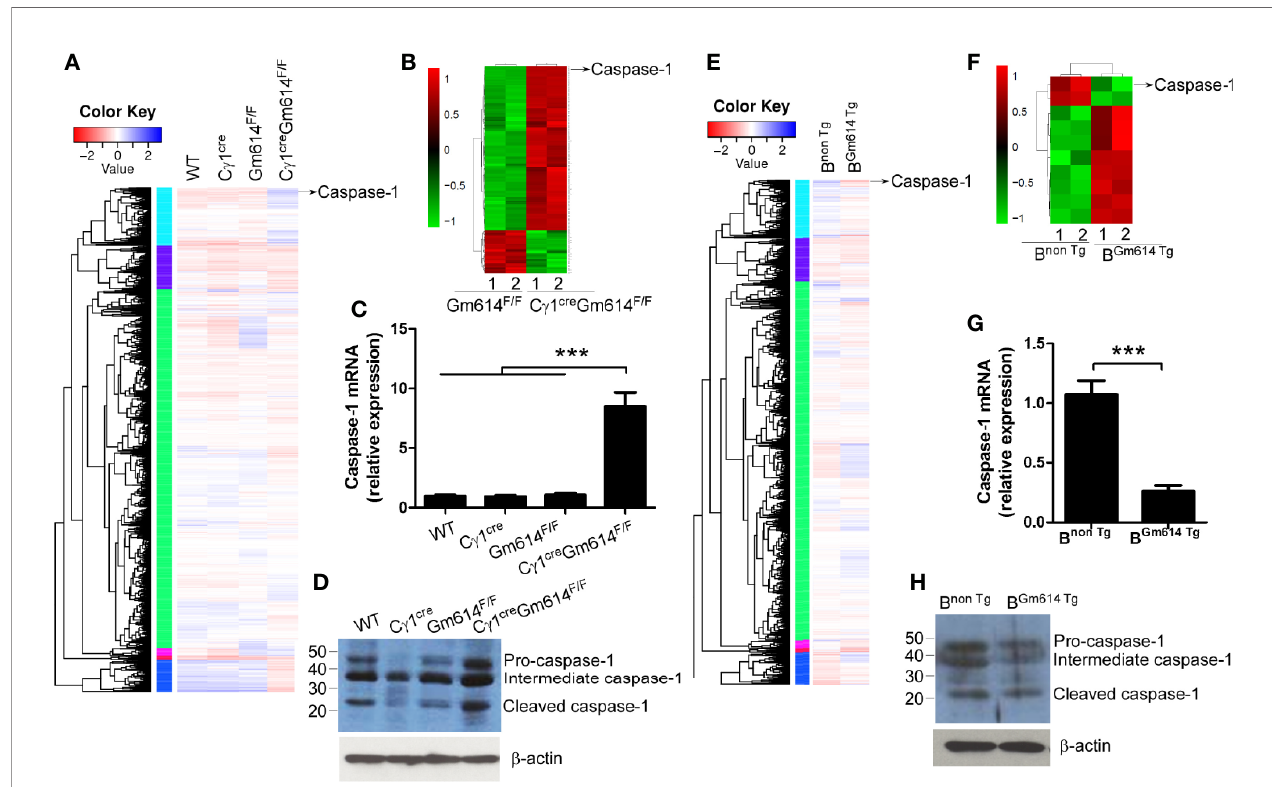
FIGURE 5 | Gm614 suppressed caspase-1 expression in GC B cells. Nine-week-old WT, C g 1 cre , Gm614 F/F , and C g 1 cre Gm614 F/F (A – D) , or B non Tg and B Gm614 Tg (E – H) mice were i.p. injected with 0.5 ml pristane and 6 months after injection, splenic CD19 + B220 + CD38 lo GL7 hi GC B cells were sorted by FACS. (A – D) Gm614 cKO up-regulated caspase-1 expression in GC B cells. The transcripts and proteomics in GC B cells were determined by RNA-sequencing (A) and iTRAQ quantitative proteomics (B) , respectively, and caspase-1 is shown. Caspase-1 mRNA and protein expression in GC B cells were determined by qPCR (C) and western blot (D) assays, respectively. (E – H) Gm614 Tg suppressed caspase-1 expression in GC B cells. The transcripts and proteomics in GC B cells were determined by RNA-sequencing (E) and iTRAQ quantitative proteomics (F) , respectively, and caspase-1 is shown. Caspase-1 mRNA and protein expression in GC B cells were determined by qPCR (G) and western blot (H) assays, respectively. (C, D, G, H) Data represent three independent experiments, with six samples per group per experiment. (C) One-Way ANOVA was followed by Bonferroni post-tests and (G) Student ’ s t-test (two tailed), Error bars, s.e.m., ***p <